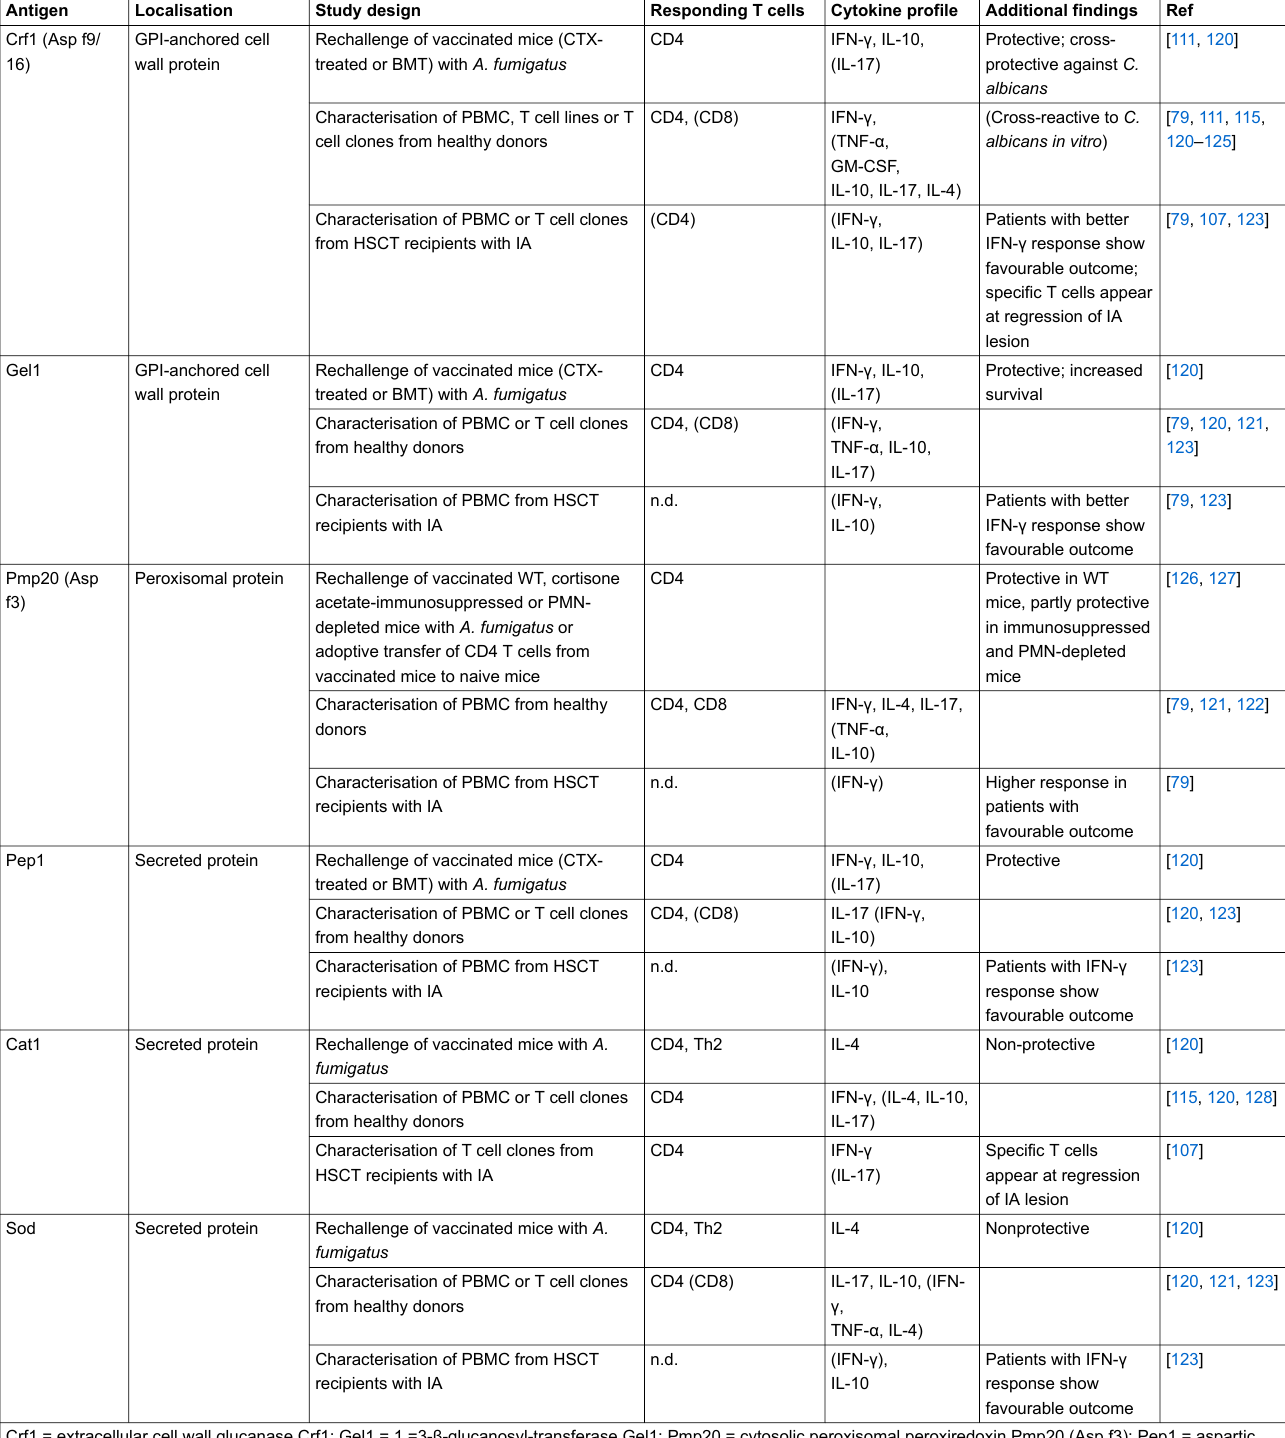
Table 2: Immunogenic A. fumigatus proteins in mice, healthy individuals and haematopoietic stem cell transplant recipients with invasive aspergillosis. Antigen